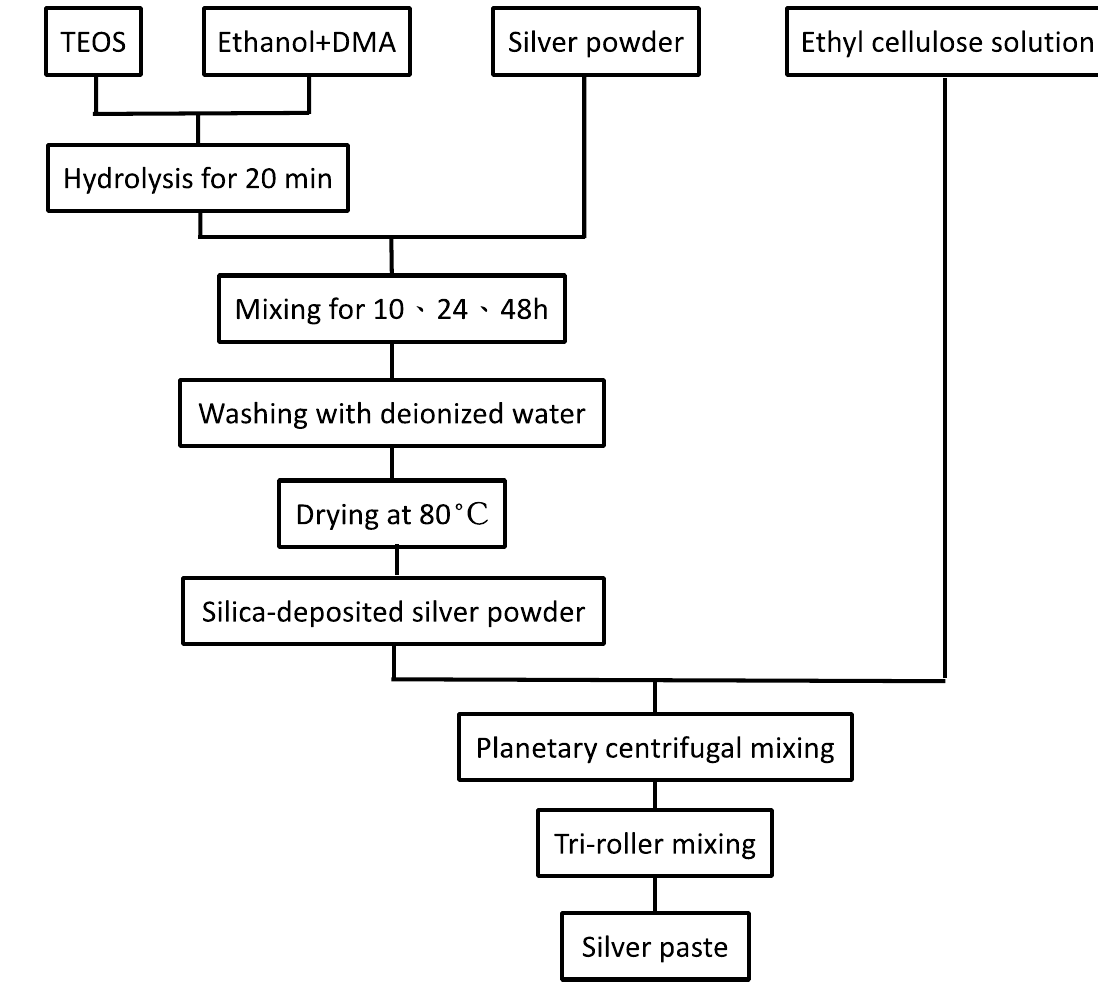
Fig. 2 Flowchart for the silver paste